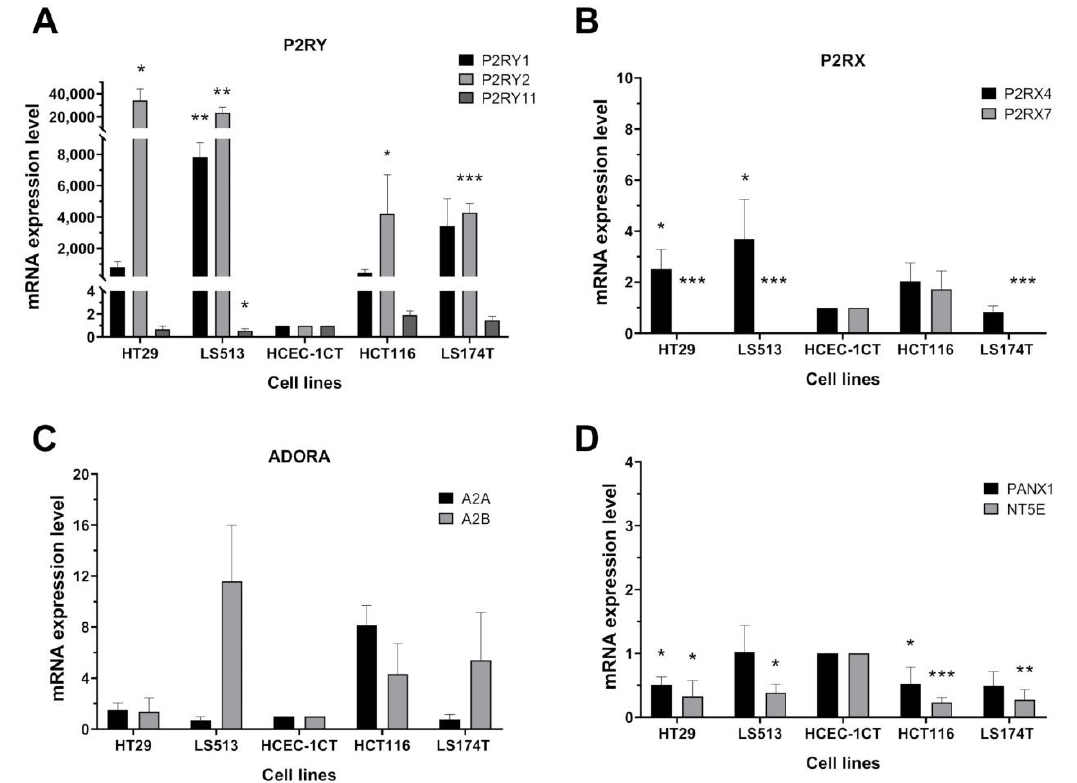
Figure 2. Transcriptional expression of purinergic receptors and ectonucleotidase coding genes in CRC cell lines. The mRNA expression levels for the indicated genes were measured in CRC (HT29, LS513, HCT116 and LS174T) and non-tumorigenic colonic (HCEC-1CT) cell lines ( n = 4) grown in 2D by quantitative Real-Time PCR and the fold changes calculated by using the 2 − ∆∆ Ct method. Briefly, for each cell line, the mRNA expression levels of the housekeeping gene 36B4 (RPL0) were used an internal control to normalize gene expression. The difference between the Ct values ( ∆ Ct) of the genes of interest and the housekeeping gene was then calculated for each experimental sample, and the difference in the ∆ Ct values between the experimental (CRC cells) and control (HCEC-1CT) samples ∆∆ Ct was calculated. Gene expression levels were expressed as the fold changes calculated for each CRC samples compared to the HCEC-1CT cells (2 − ∆∆ C ). The mRNA expression of ( A ) ATP metabotropic P2Y receptors, ( B ) ATP ion channel P2X4 and P2X7 receptors, ( C ) adenosine ADORA receptors, and ( D ) the ectonucleotidase CD73 and ATP release hemichannel Pannexin-1 are shown. Data are expressed as the mean +/ − SD. p values were calculated using Student’s paired t -test: * p < 0.05, ** p < 0.01, *** p < 0.005.